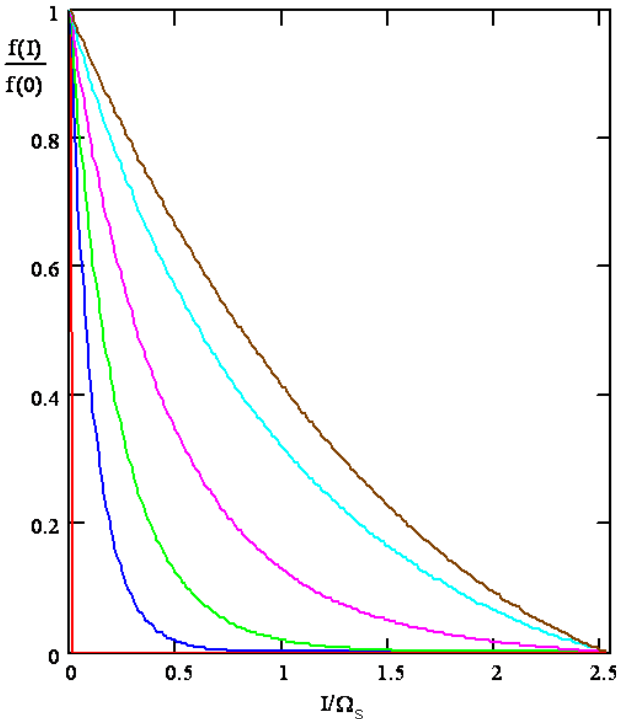
FIG. 3. (Color) Time dependence of beam intensity (top) and rms bunch length and momentum spread